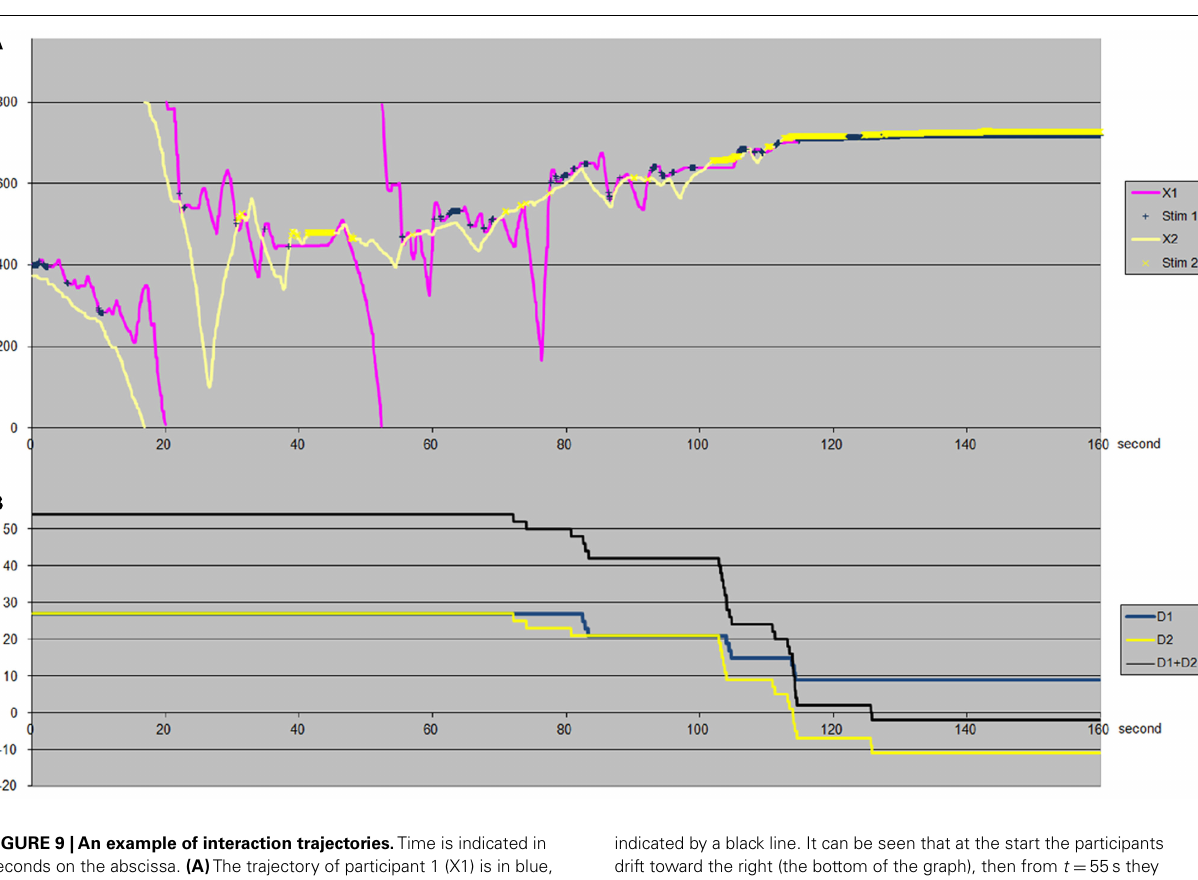
indicated by a black line. It can be seen that at the start the participants drift toward the right (the bottom of the graph), then from t = 55s they start to drift toward the left (the top of the graph) but slower and slower as they progressively stabilize. At the start the displacement ( D 1 + D 2) is 60pixels ( D 1 = D 2 = 30).The participants start clicking from t = 72s. From t = 125s onward, the two subjects both receive a continuous stimulation and they stop moving: ( D 1 + D 2) =